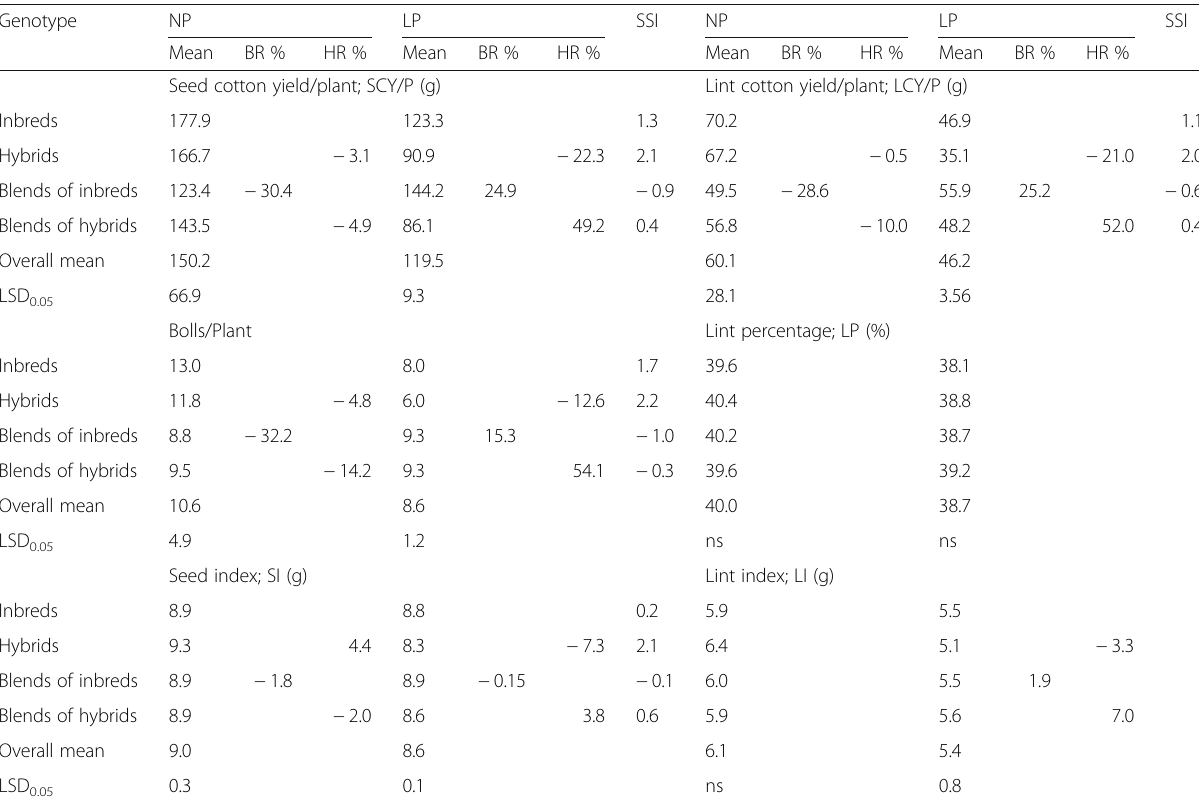
Table 4 Grand mean performance, blend response (BR %), heterotic response (HR %) and susceptibility index (SSI) for four populations of cotton genotypes cultivated in normal and late planting date Genotype